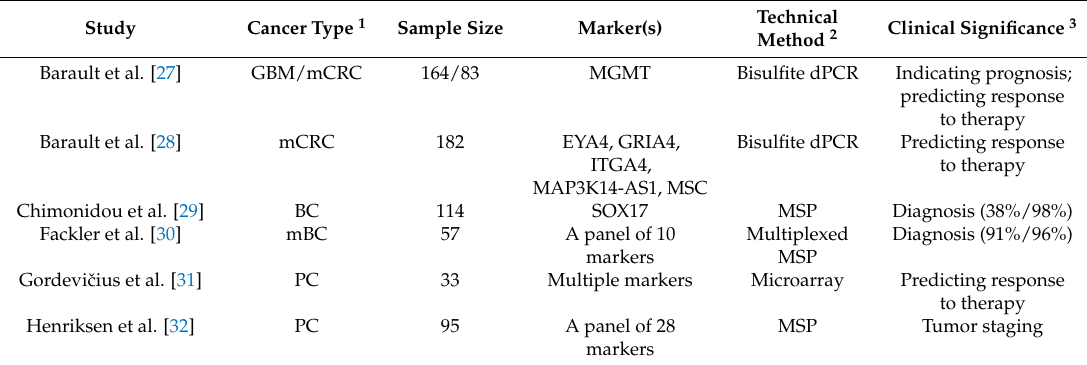
Table 1. Summary of recent DNA methylation-based cancer liquid biopsy